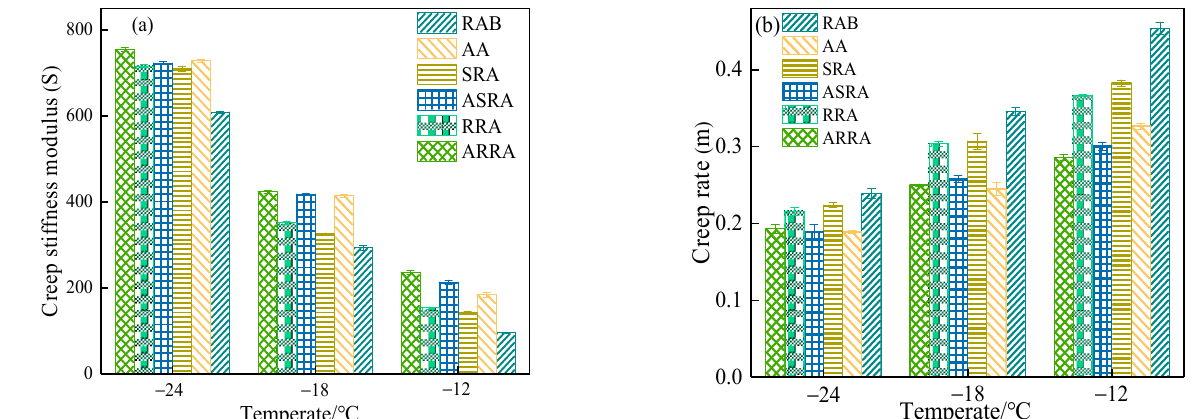
Figure 5. ( a ) Creep stiffness modulus and ( b ) creep rate.